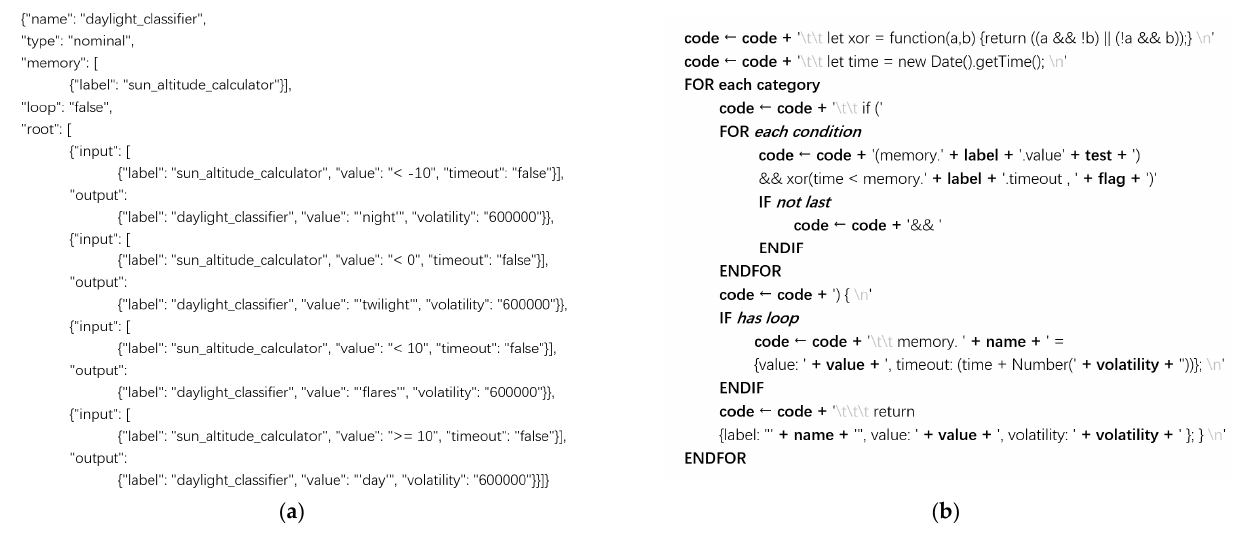
Figure 9. ( a ) The JSON configuration for the daylight-classifier node that uses feedforward nominal processing. ( b ) The pseudocode of the server components that compiles the nominal processing JSON file delivering JavaScript code.